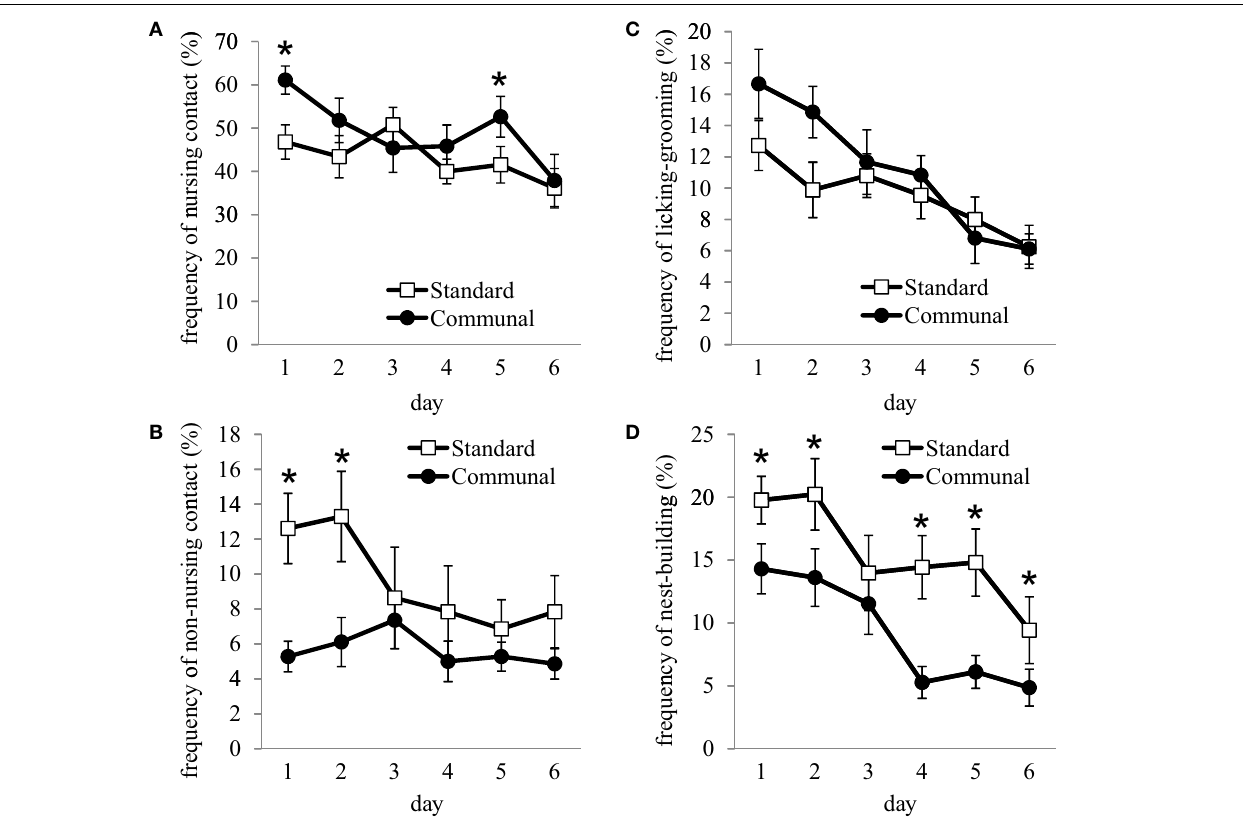
FIGURE 1 | Postpartum maternal behavior amongst females rearing pups in standard vs. communal nests. Frequency of (A) nursing-contact was signifi cantly elevated amongst communal females whereas (B) non-nursing contact was reduced in communal compared to standard rearing females.